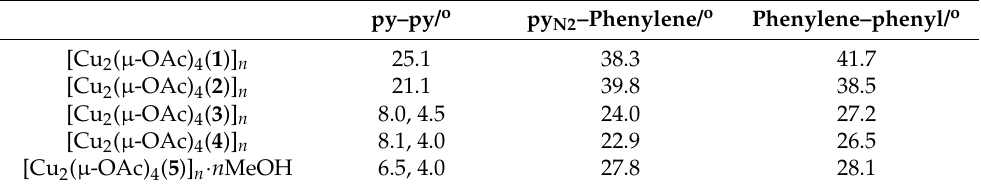
Table 2. Angles between ring-planes in the copper(II) coordination polymers.